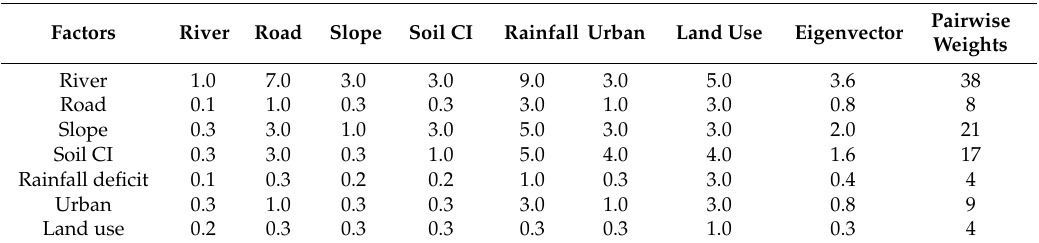
Table 4. Irrigation suitability factors’ weight calculation from river/rainwater harvest based on expert